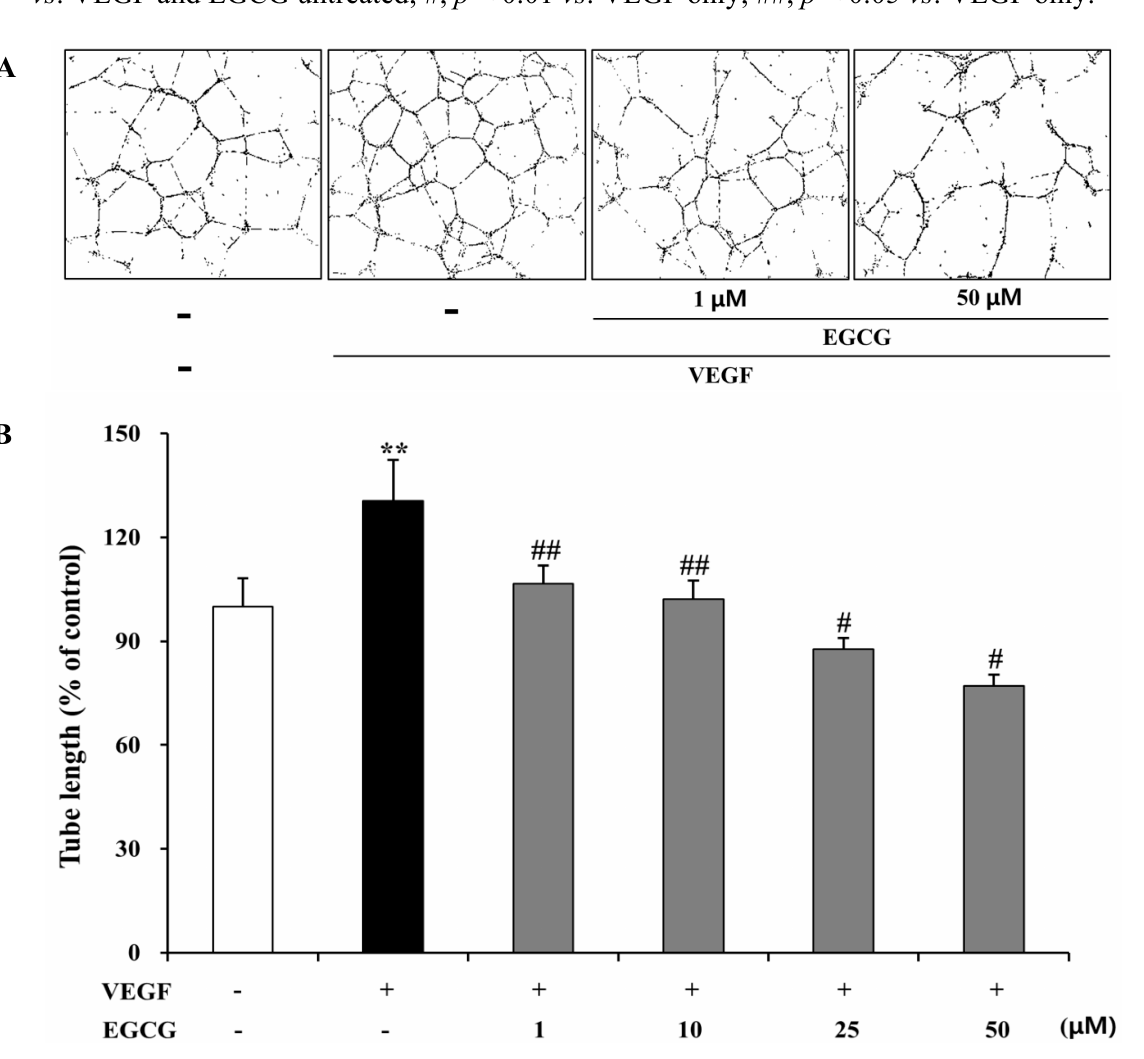
Figure 7. Inhibitory effect of EGCG on tube formation by HRMECs. ( A ) HRMECs were inoculated on the surface of the basement membrane matrix and treated with 10 ng/mL VEGF or 1–50 μ M EGCG for 24 h. Figures were selected as representative photographs from three independent experiments; ( B ) Tube formation was observed in three randomly chosen fields, and the basal tube length of HRMECs without VEGF and EGCG (1–50 μ M) was normalized to 100%. Tube length was measured using an image analyzer. The results are expressed as percentage of control and are presented by mean ± SD (n = 9). ** , p < 0.05 vs . VEGF and EGCG untreated; #, p < 0.01 vs . VEGF only; ##, p < 0.05 vs . VEGF